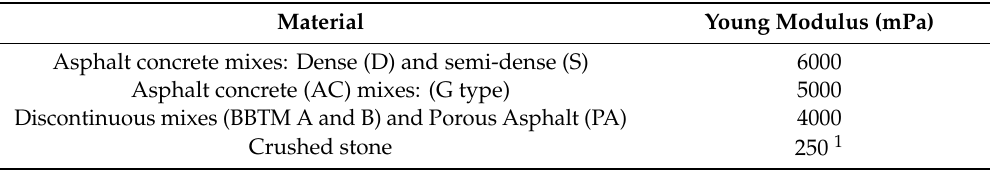
Table 2. Values of the Young modulus for di ff erent bituminous materials. Material Young Modulus (mPa) Asphalt concrete mixes: Dense (D) and semi-dense (S) 6000 Asphalt concrete (AC) mixes: (G type) 5000 Discontinuous mixes (BBTM A and B) and Porous Asphalt